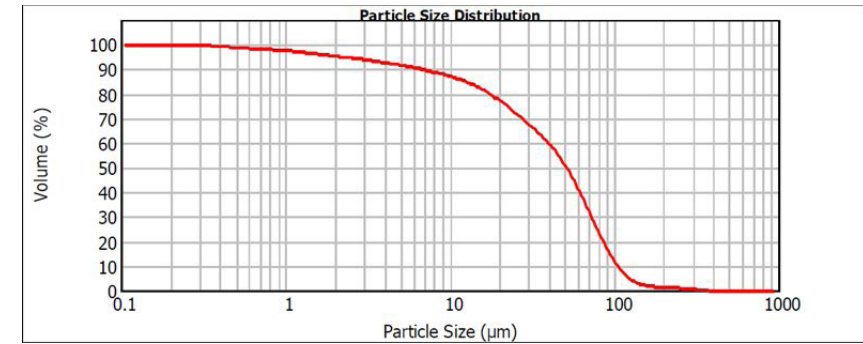
Figure 2. Particle size distribution by laser